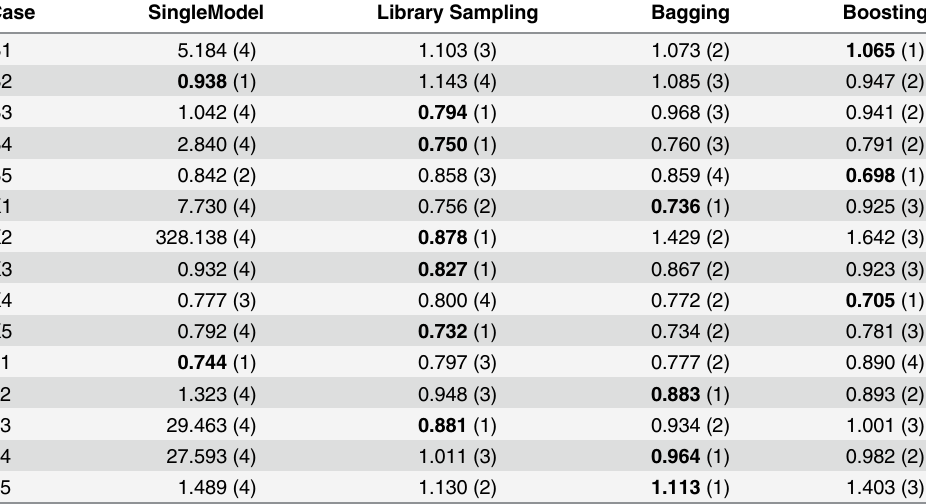
Table 2. Comparison of the predictive performance of a single model with that of ensembles of PBMs learned with library sampling, bagging and boosting.